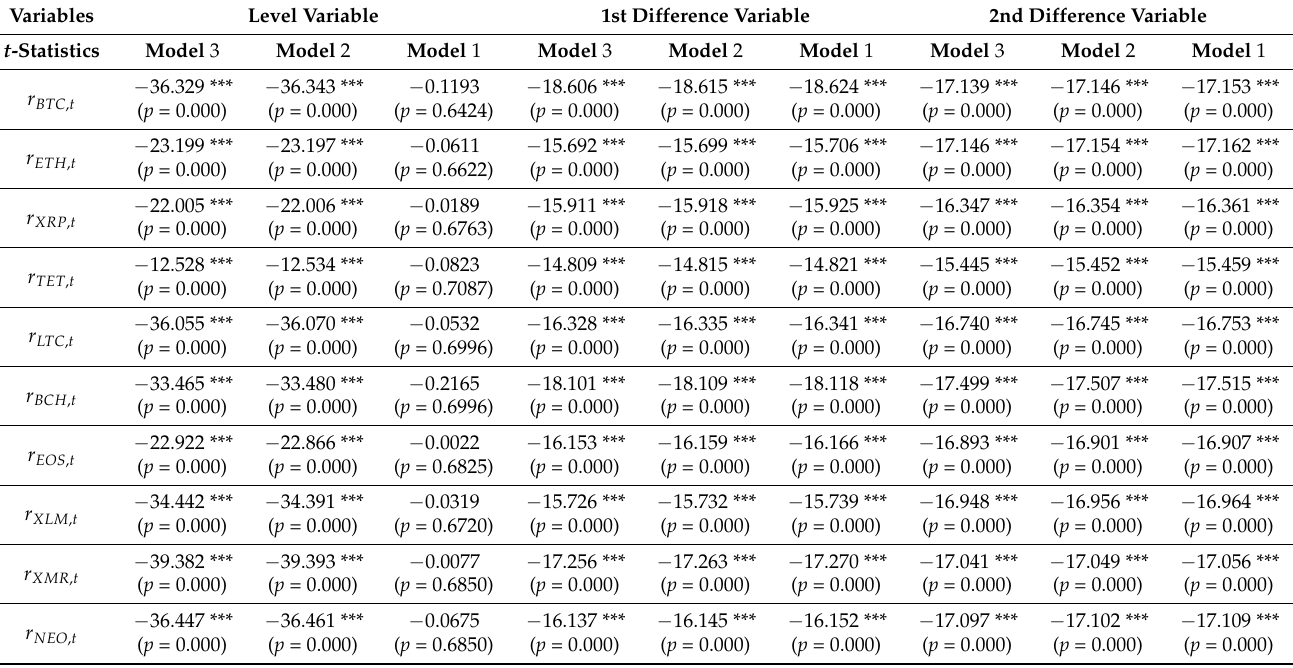
Table 7. t-statistics of the ADF unit root test for the level, 1st, and 2nd difference variables of the 10 cryptocurrencies’ return indices for the full